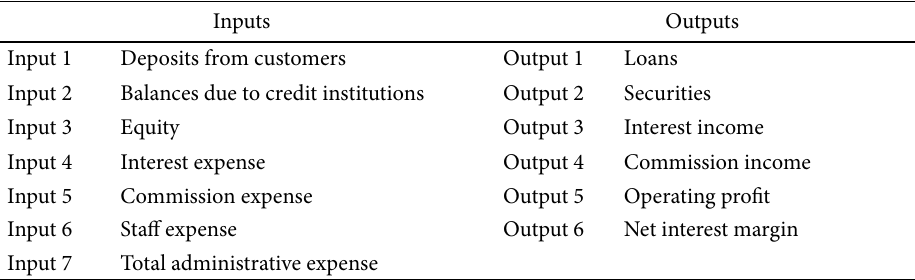
Table 3. List of potential model variables